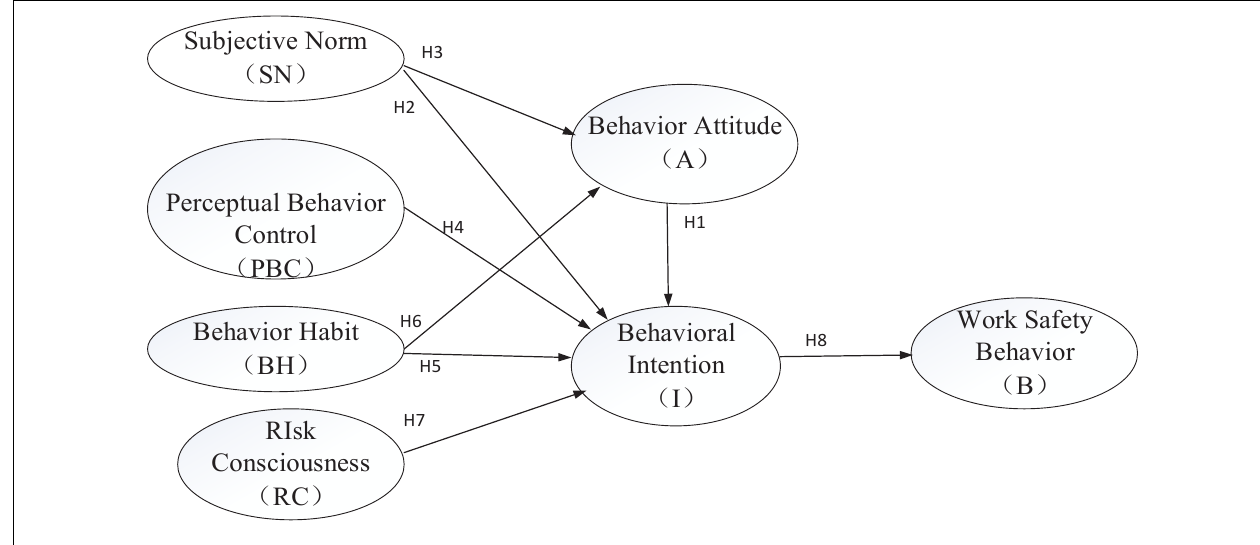
FIGURE 2 | A conceptual model for the influence mechanism of MSEs’ work safety behavior in high-risk